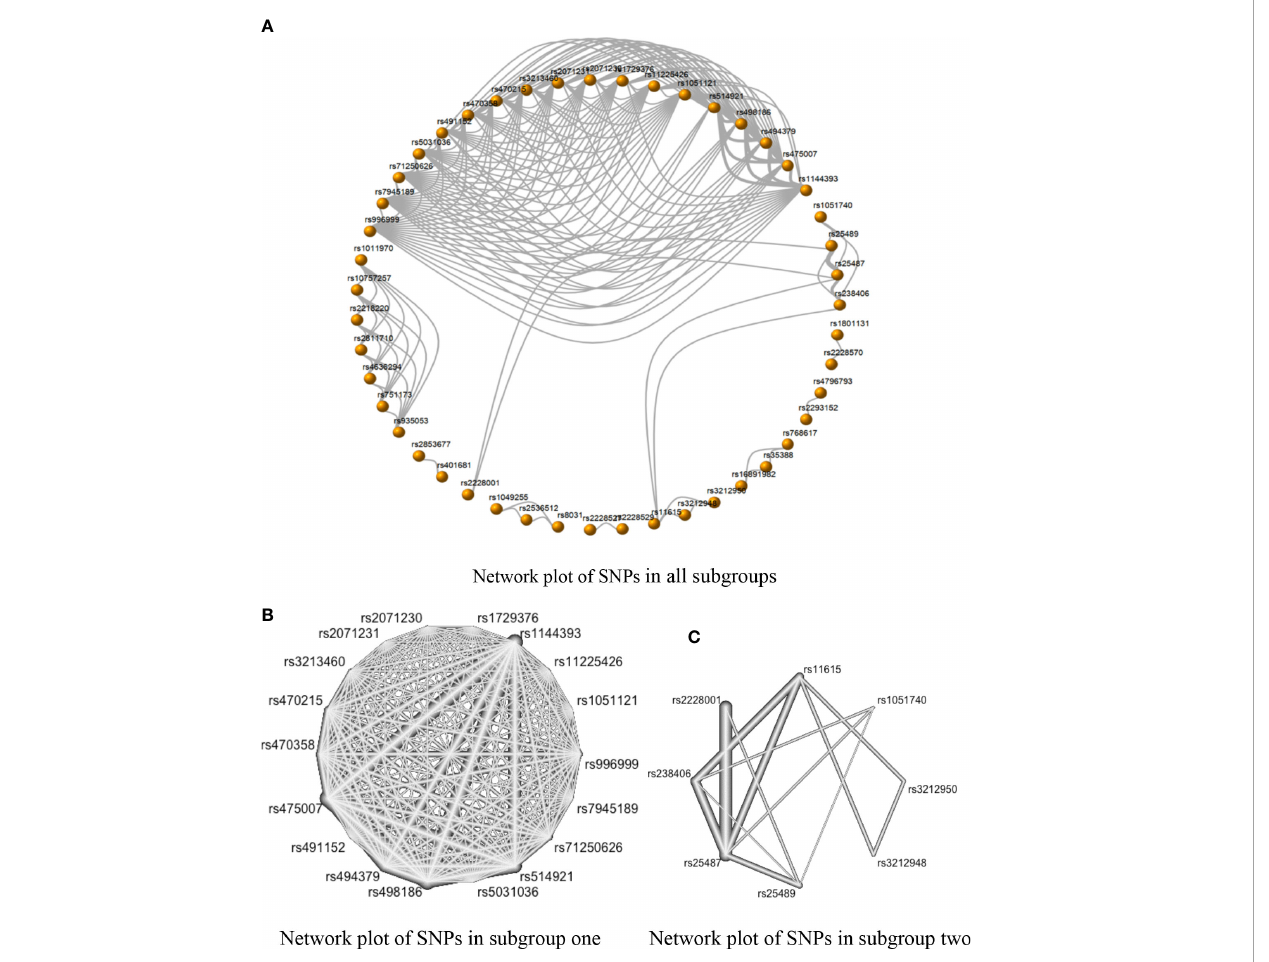
FIGURE 4 The network evidence plots of single nucleotide polymorphisms (SNPs) in the dominant model (AA + AB vs. BB). (A) Network map with 47 SNPs of all subgroups in the dominant model; (B) Network map of subgroup one with 18 SNPs in the dominant model; and (C) Network map of Subgroup two with eight SNPs in the dominant